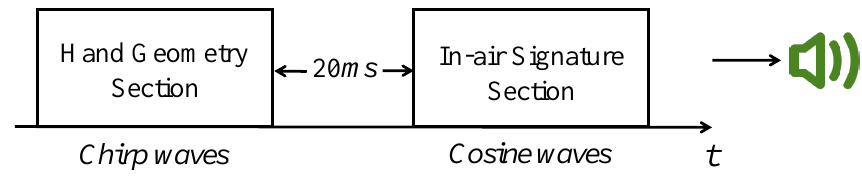
Figure 3. Sound signal design